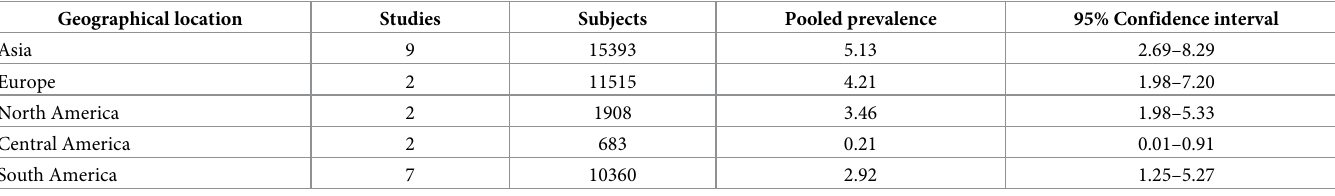
Table 3. Pooled prevalence of aerophagia related to geographical